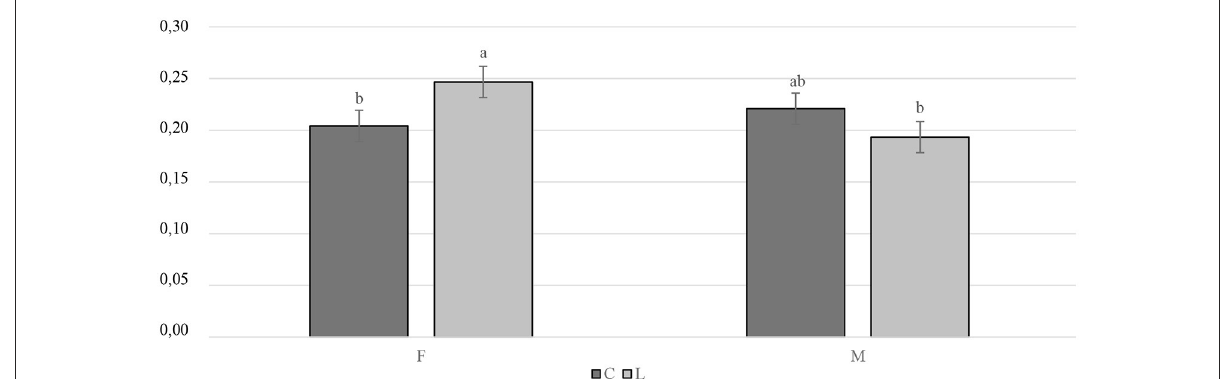
FIGURE4 Interaction effect (gender × diet) on the bursa of Fabricius relative weight of the Label Rouge Naked Neck birds fed a diet supplemented with 10% live black soldier fly larvae; supplementation based on the expected daily feed intake, (28–81 d; n = 6). a, b indicate significant differences at P < 0.05; F, females; M, males; C, control; L, larvae.